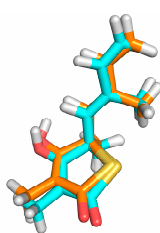
Figure 3 . Result of the redocking. Crystallographic ligand in cyan and the best docking pose in orange.